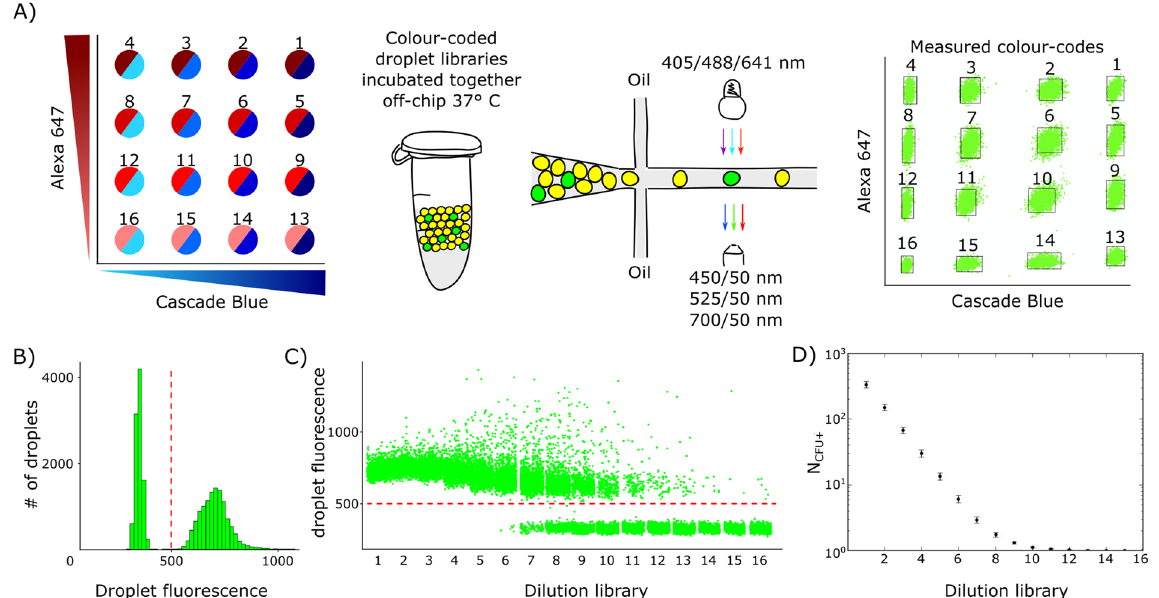
Figure 2. A colour-coded droplet virtual array reveals inoculum density. ( A ) Schematic for colour-coding bacterial densities. Cascade Blue and Alexa 647 dyes are represented in the virtual array as a 4 × 4 concentration matrix of 16 colour-code combinations (darker colour corresponds to higher dye concentration). Two-fold serial dilutions of bacteria are colour-coded and introduced sequentially into the microfluidic system for droplet generation. Colour-coded droplet libraries are pooled into a single master library. After incubation, droplet fluorescence is acquired in three separate channels (three arrows). Droplets are gated to 16 bins in a virtual array based on their Cascade Blue and Alexa 647 signal intensities (virtual array with ~22000 droplets). ( B ) Histogram of the pooled droplet signals, with bacterial growth in the green channel. Red dashed line denotes the threshold between negative and positive droplets. ( C ) Plot of bacterial growth (relative fluorescence of droplet in green channel) measured separately in each droplet. Droplets are sorted according to their colour- code allocation in the virtual array (the same data as in ( A , B ). Note the substantial population of droplets with high fluorescence intensity (near 1000 and above). This phenomenon is explained in “clumping” section. ( D ) Average number of bacteria in non-empty droplets ( N CFU + ) in various virtual array libraries (Fig.